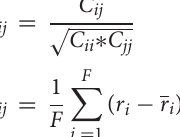
FIGURE 3 | Structure of the active site in p53 Y220C that is used as the QM region in QM/MM MD simulations. The protein is shown as a gray cartoon representation and selected residues are highlighted as stick models. The halogen bond between the iodine and the carbonyl oxygen of Leu50 is indicated by a yellow dash line. Additional polar interactions between iodine and water are shown as orange dash lines. Water 1 to water 3 were named as W1 to W3 in this